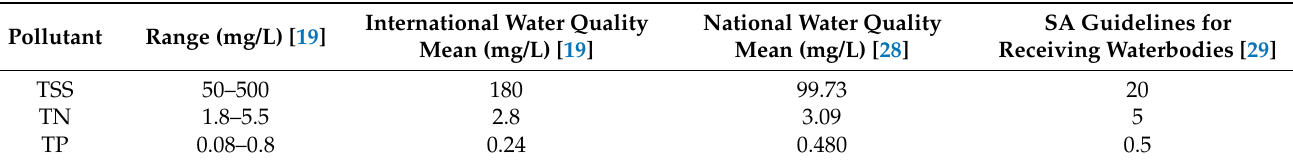
Table 3. Range of stormwater pollutants as reported in international literature for stormwater quality. South Australia guidelines are also provided for receiving water bodies as